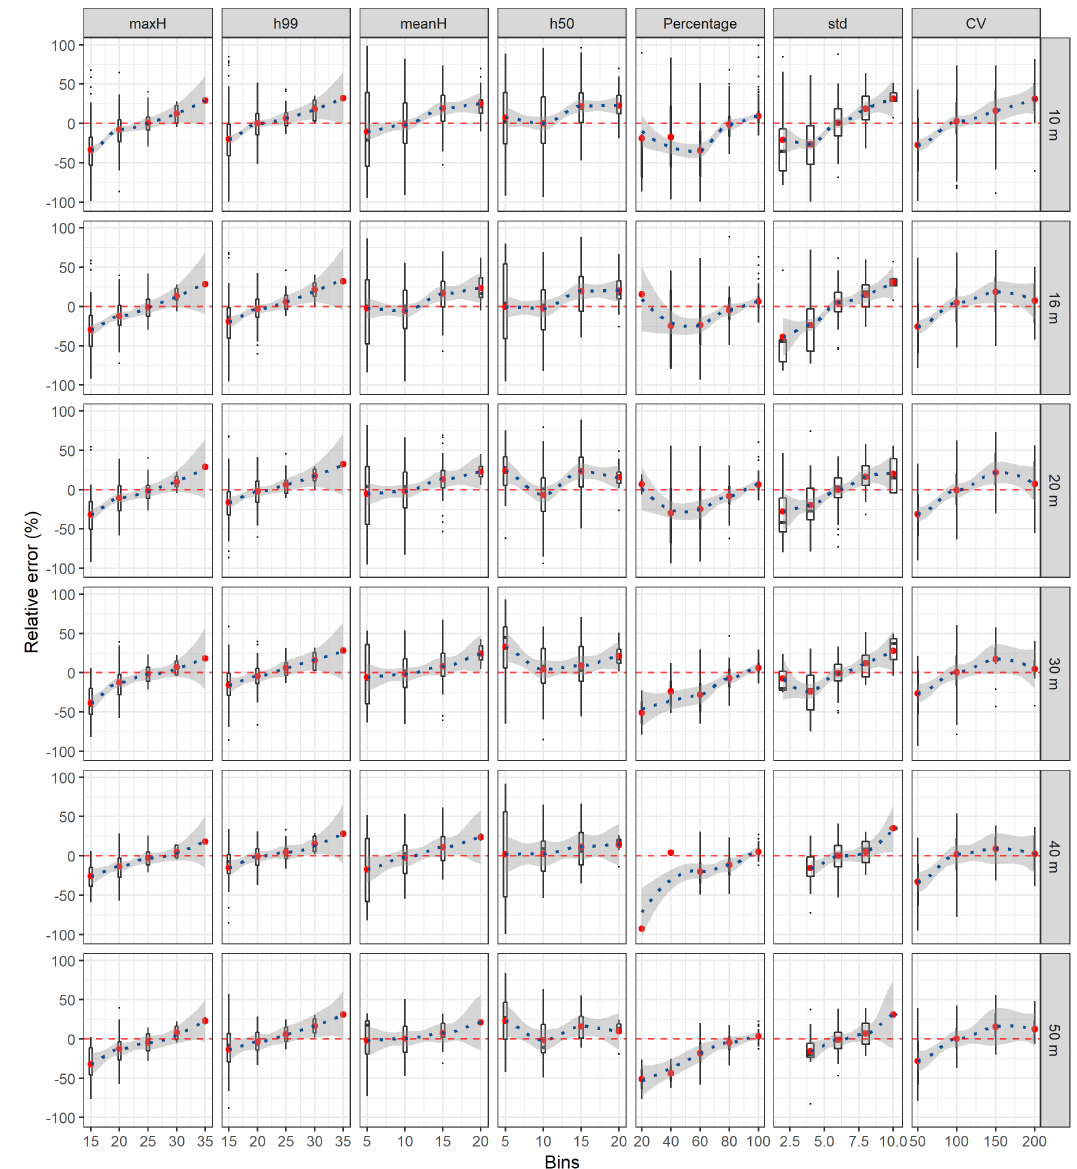
Figure 17. The relative error distribution of different bins for metrics at various scale sizes. The vertical y-axis represents the relative error (measurements from G-LiHT are used as reference values); the numbers in horizontal x-axis represent certain bin sizes. For example, in maxH graph, 15 stands for tree height within 0–15 m; 20 stands for 15–20 m; 25 stands for 20–25 m; 30 stands for 25–30 m; 35 stands for tree height above 30